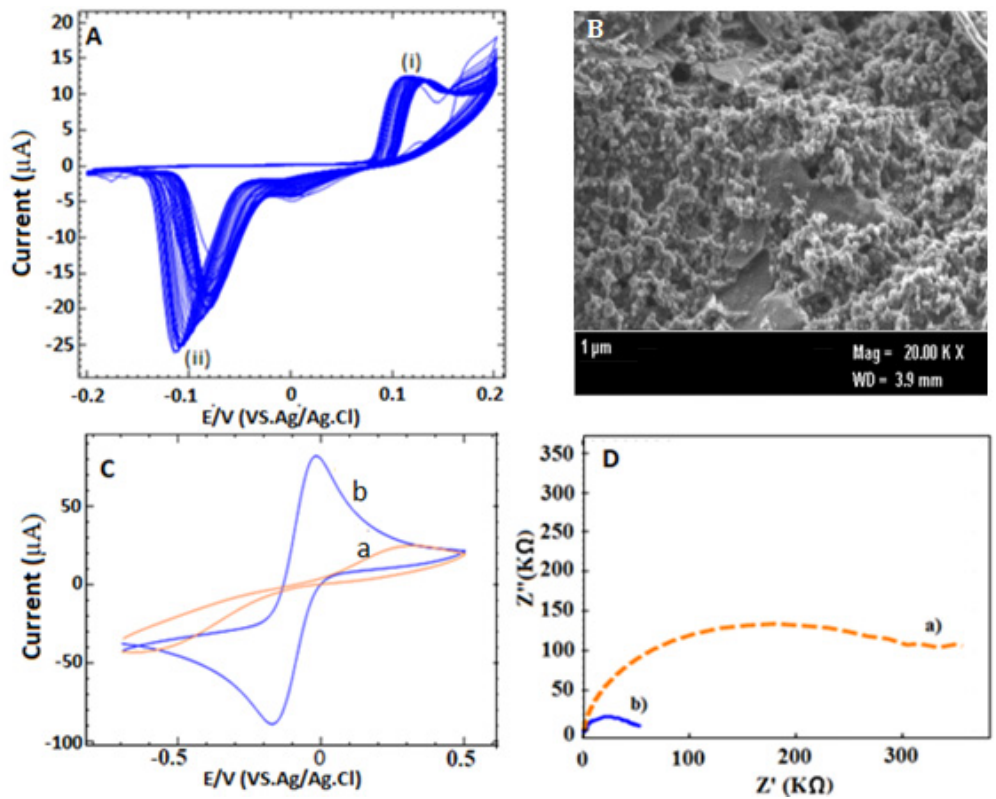
Figure 2. ( A ) CV electrodeposition of CDs on SPCE from an aqueous solution of CDs; (B )